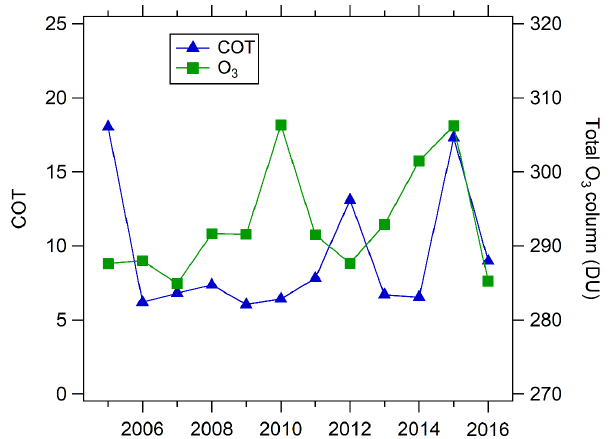
Figure 9. Variations in mean total ozone column and cloud optical thickness (COT) in Beijing for the month of August during 2005–